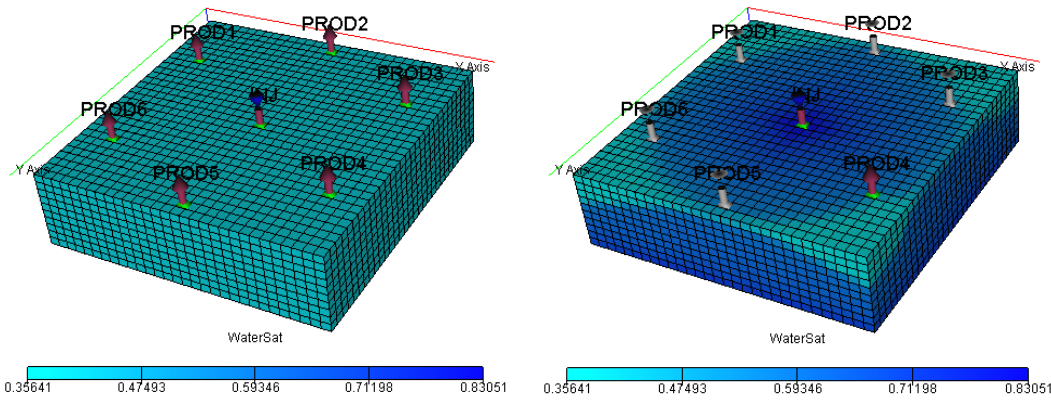
Figure 28. 3D simulated water saturation ( a ) before and ( b ) after 1840 days of simulation.